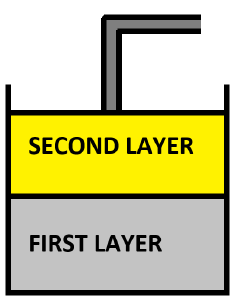
Figure 2. Diagram of the double-layered configuration consisting of skin mimicking phantom as the first layer and olive oil or triton X-100 as the second